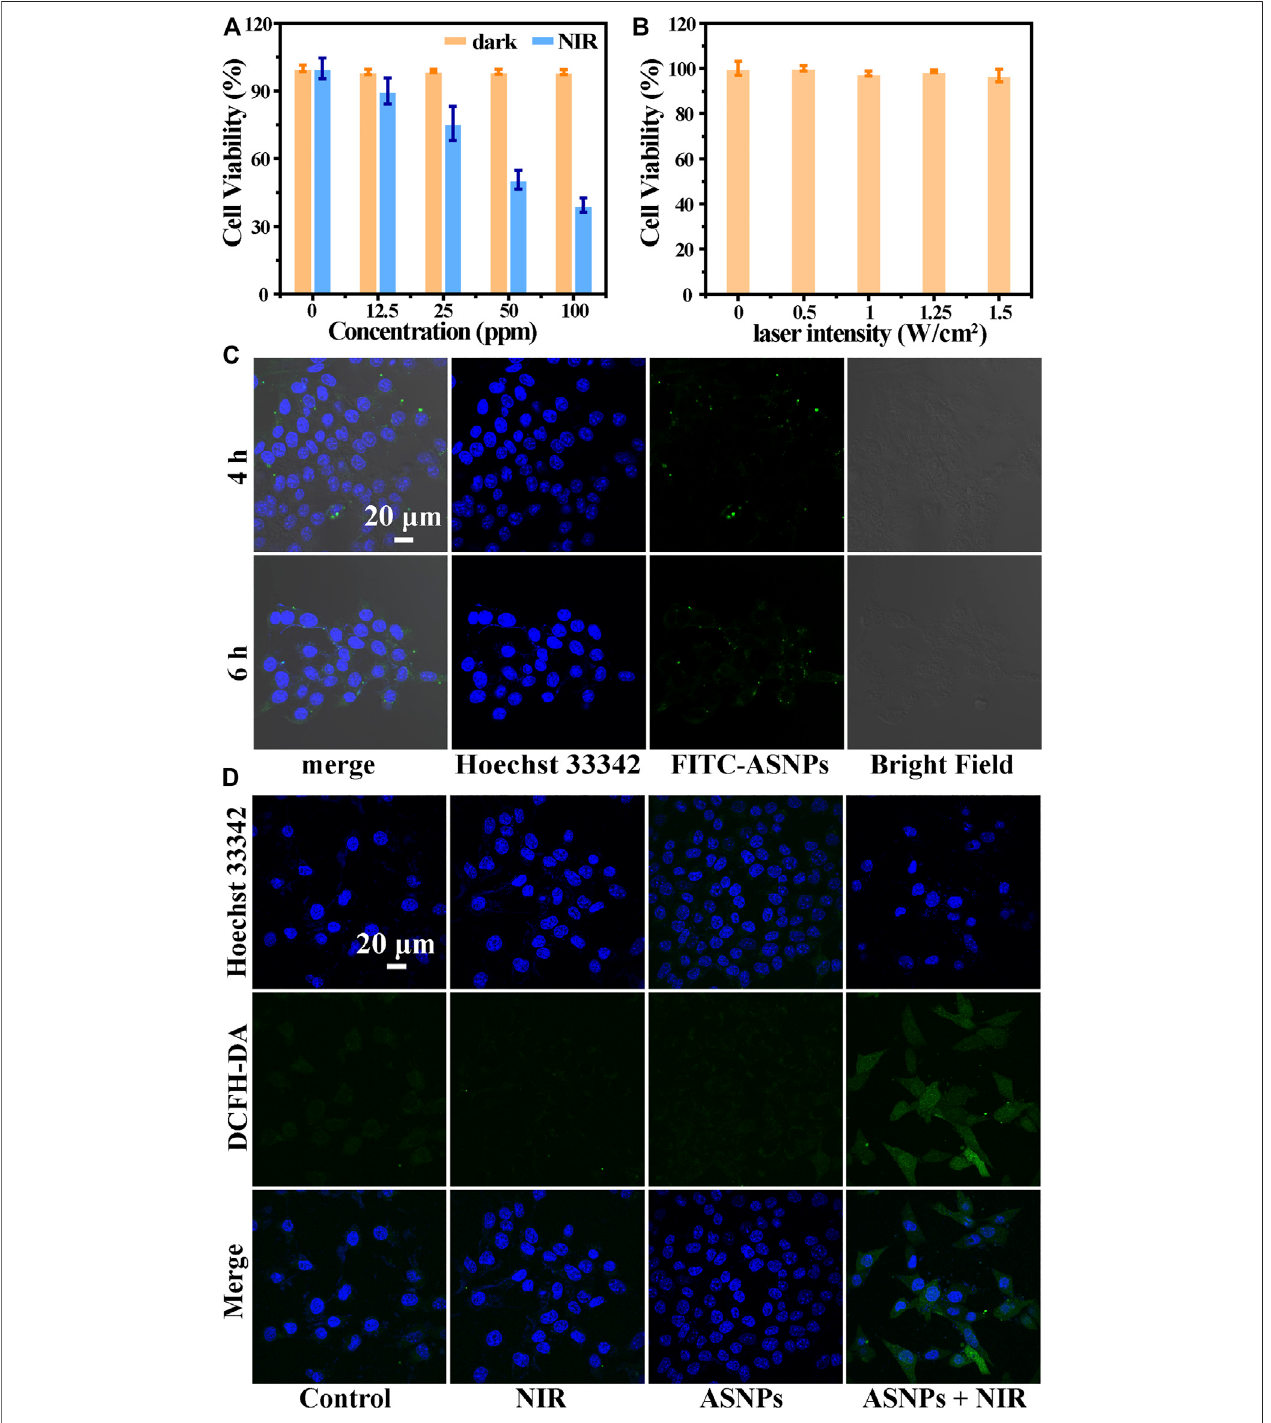
FIGURE5|(A) Cellviabilityof4T1cellscoincubatedwithdifferentconcentrationsofASNPswithorwithoutNIRirradiation( n =5,mean±SD). (B) Cellviabilityof4T1 cells irradiated with different laser intensities (0, 0.5, 1, 1.25, and 1.5 W/cm 2 ) ( n = 5, mean ± SD). (C) Cellular uptake of ASNPs. 4T1 cells coincubated with FITC-labeled ASNPs for 4 or 6 h. Scale bar = 20 μ m. (D) Confocal images of 4T1 cells stained with DCFH-DA in each group. Scale bar = 20 μ m.